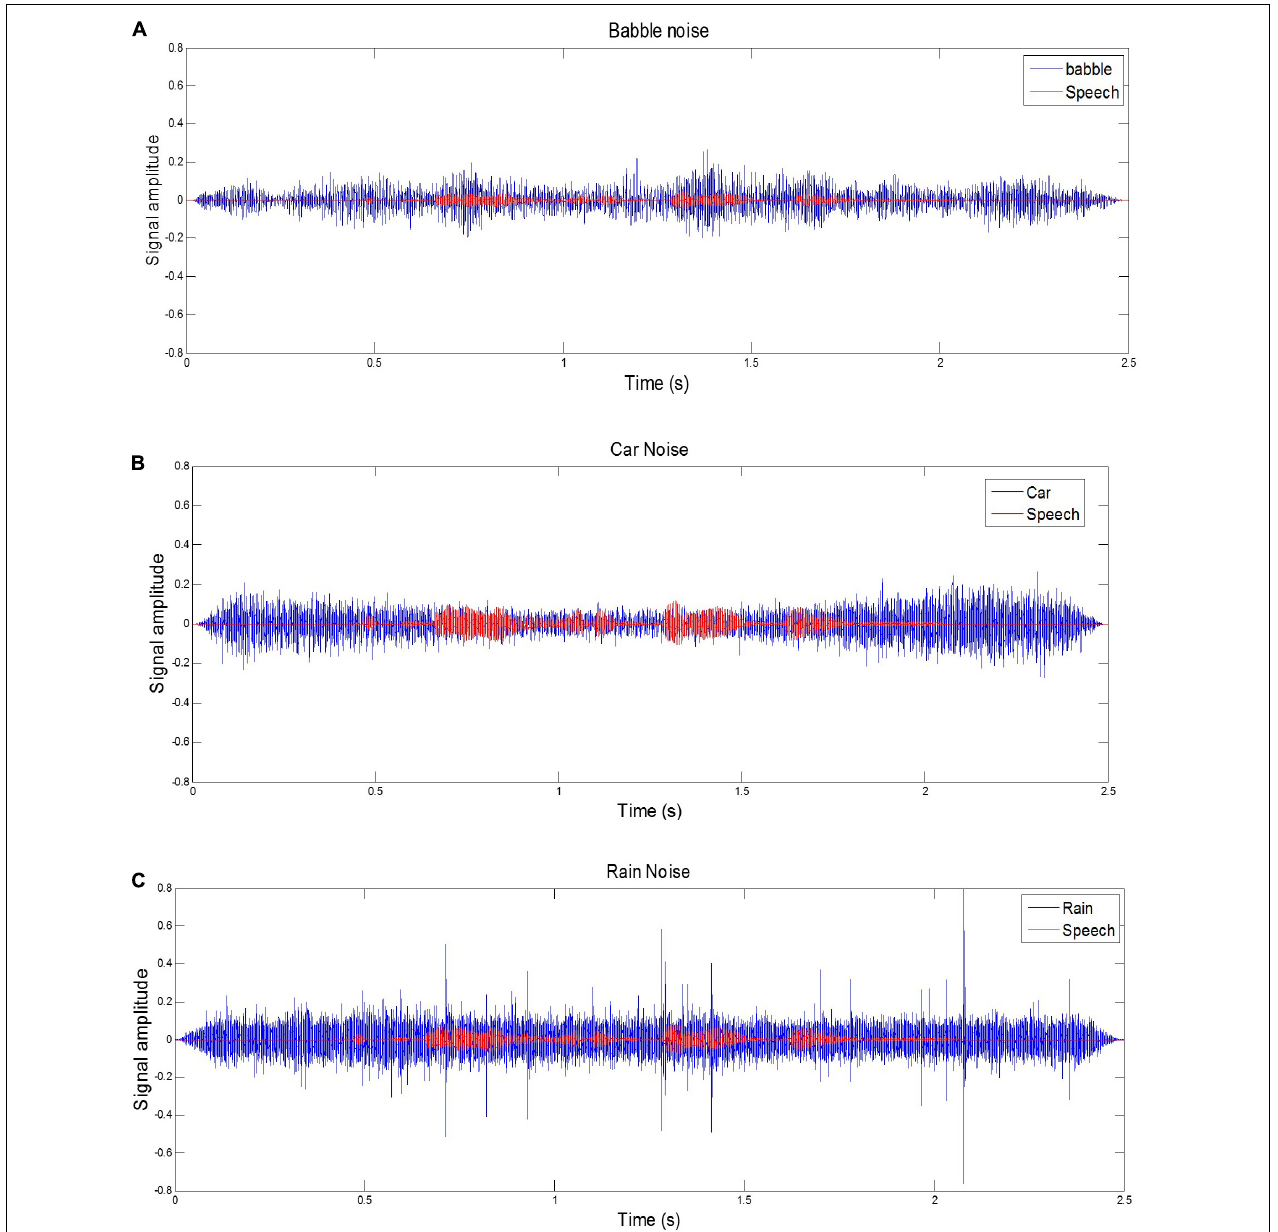
FIGURE 1 | Examples of a target sentence (“The clown had a funny face”) in the background noise of babble, car and rain. The line series are shown for (A) target sentence in babble noise with SNR –20 dB. (B) target sentence in car noise with SNR –12 dB, (C) target sentence in rain noise with SNR –15